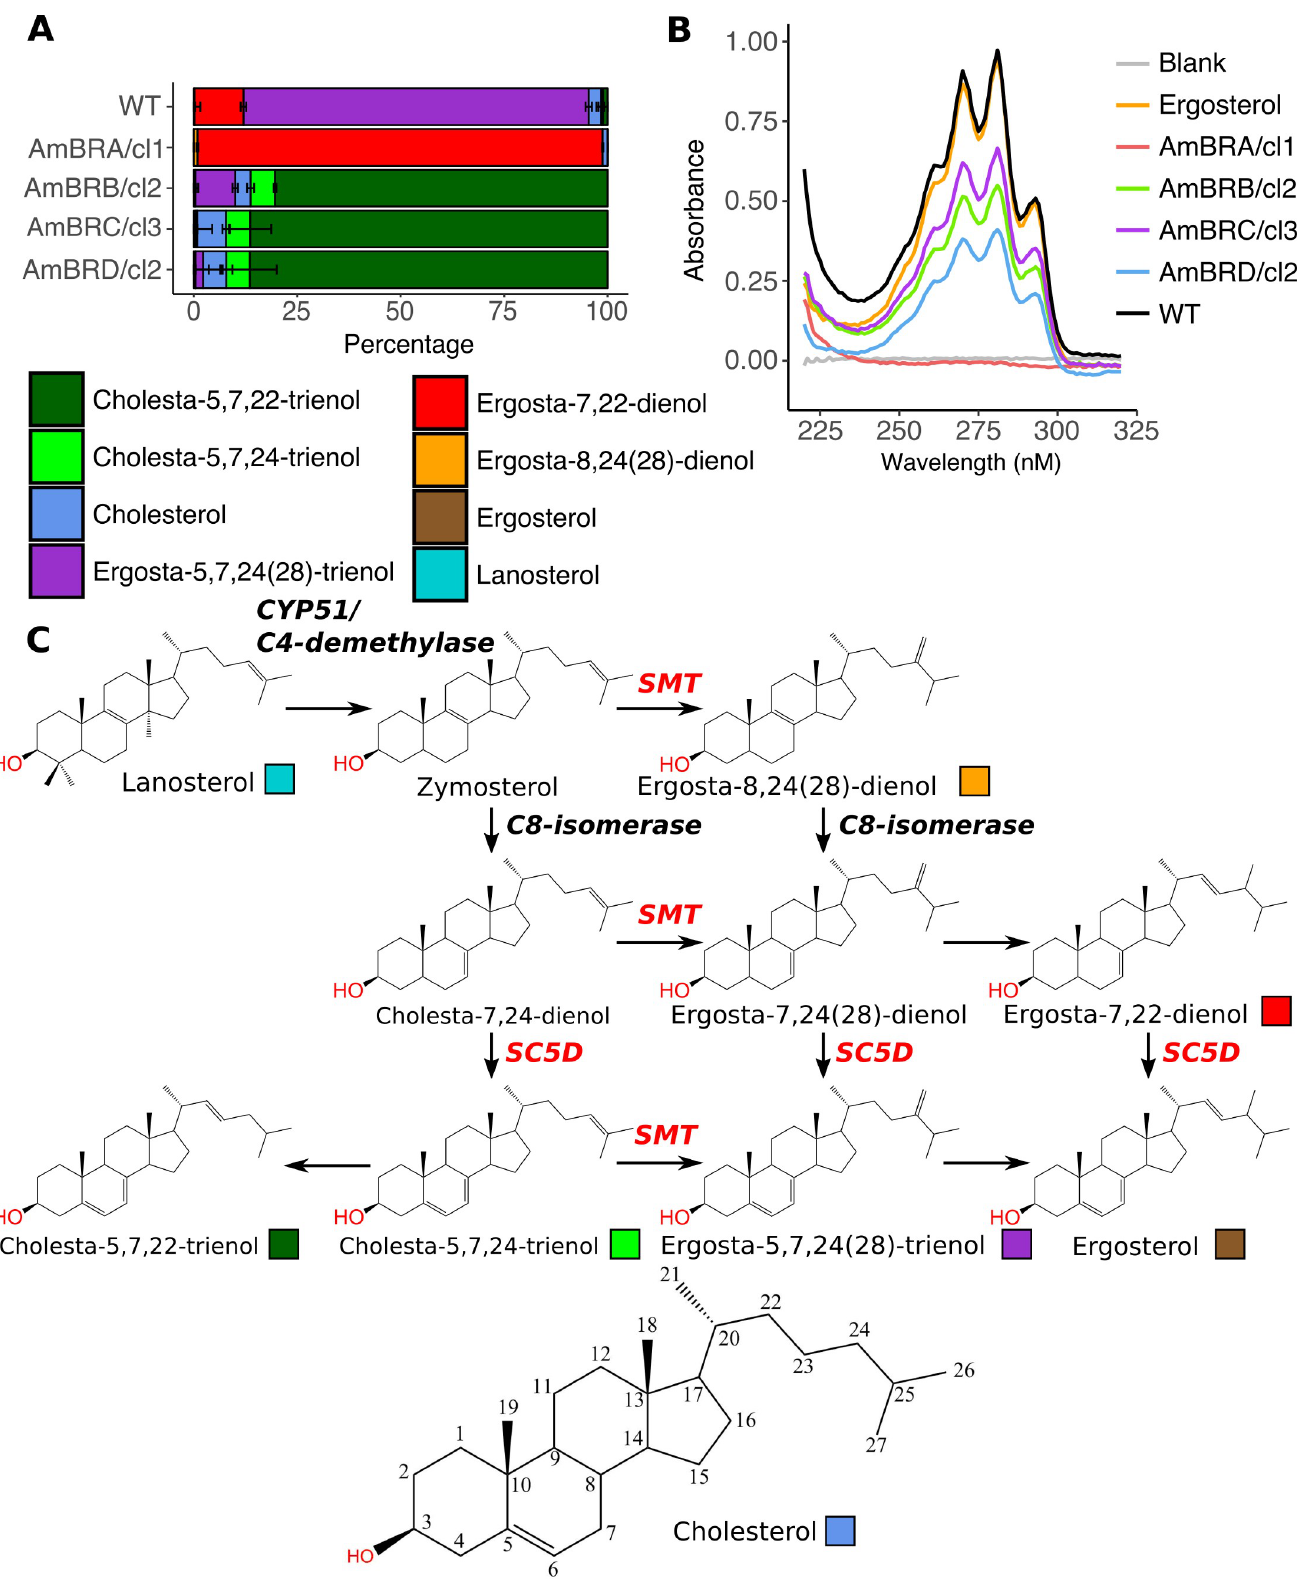
Fig 1. Changes to sterol composition in AmB-resistant parasites. A) Percentage sterol composition, as determined by GC-MS. Error bars represent standard deviation of the mean, n = 3. B) UV absorbance spectra of sterol extracts. Ergosterol dissolved in n heptane (0.05 mg/ml) is used as a standard, and n -heptane as a blank. Representative of three independent biological replicates. C) Sterol biosynthesis pathway in Leishmania , showing the structures of sterols identified in wild- PLOS NeglectedTropical Diseases | https://doi.org/10.1371/journal.pntd.0007052 February 4,